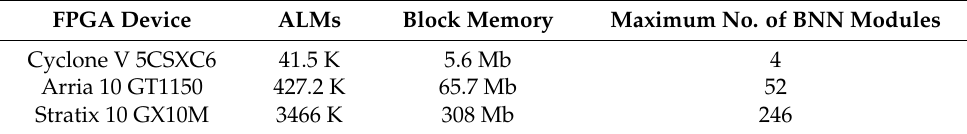
Figure 8. BNN model FPGA design synthesis results. Table 1. Describes different FPGA chips’ capability of replicating BNN modules.